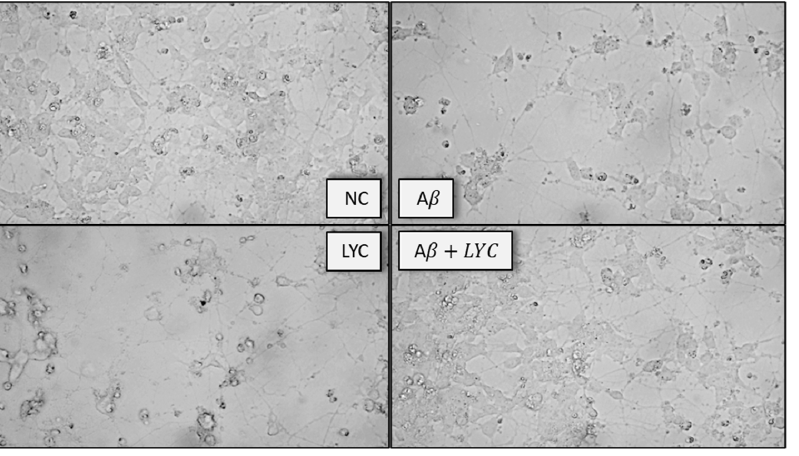
Figure 8. Optical microscope images of differentiate SH ‐ SY5Y in contact with Negative Control (NC), A β 42 2 μ M; LYC 8 μ M; A β 42 2 μ M + LYC 8 μ M. Magnification 40x; scalebar 5 μ